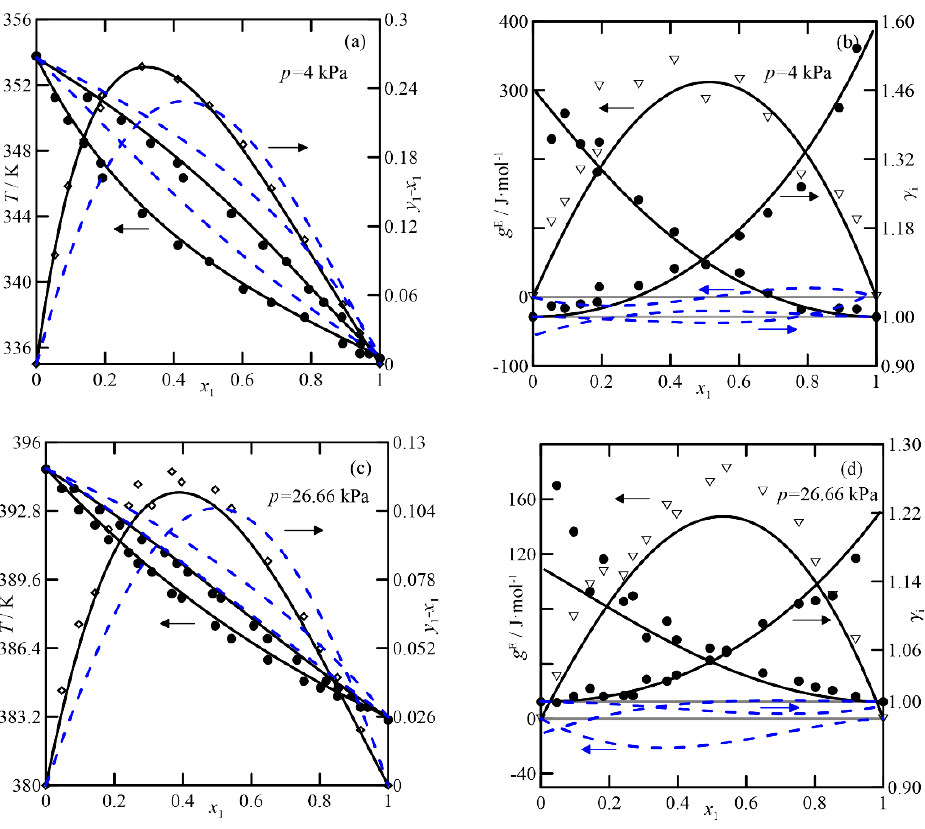
Figure 5. Iso- p VLE at 4 kPa ( a , b ) and 26.66 kPa ( c , d ) of the cyclohexanone + cyclohexanol system [3]; (—-) UNIFAC-DM; (- - -) COSMO-RS. ( • ) T ,x,y (a,c)/ γ i ( b , d ); ( ¯ ) (y − x ), x ; ( σ ) g E / RT .